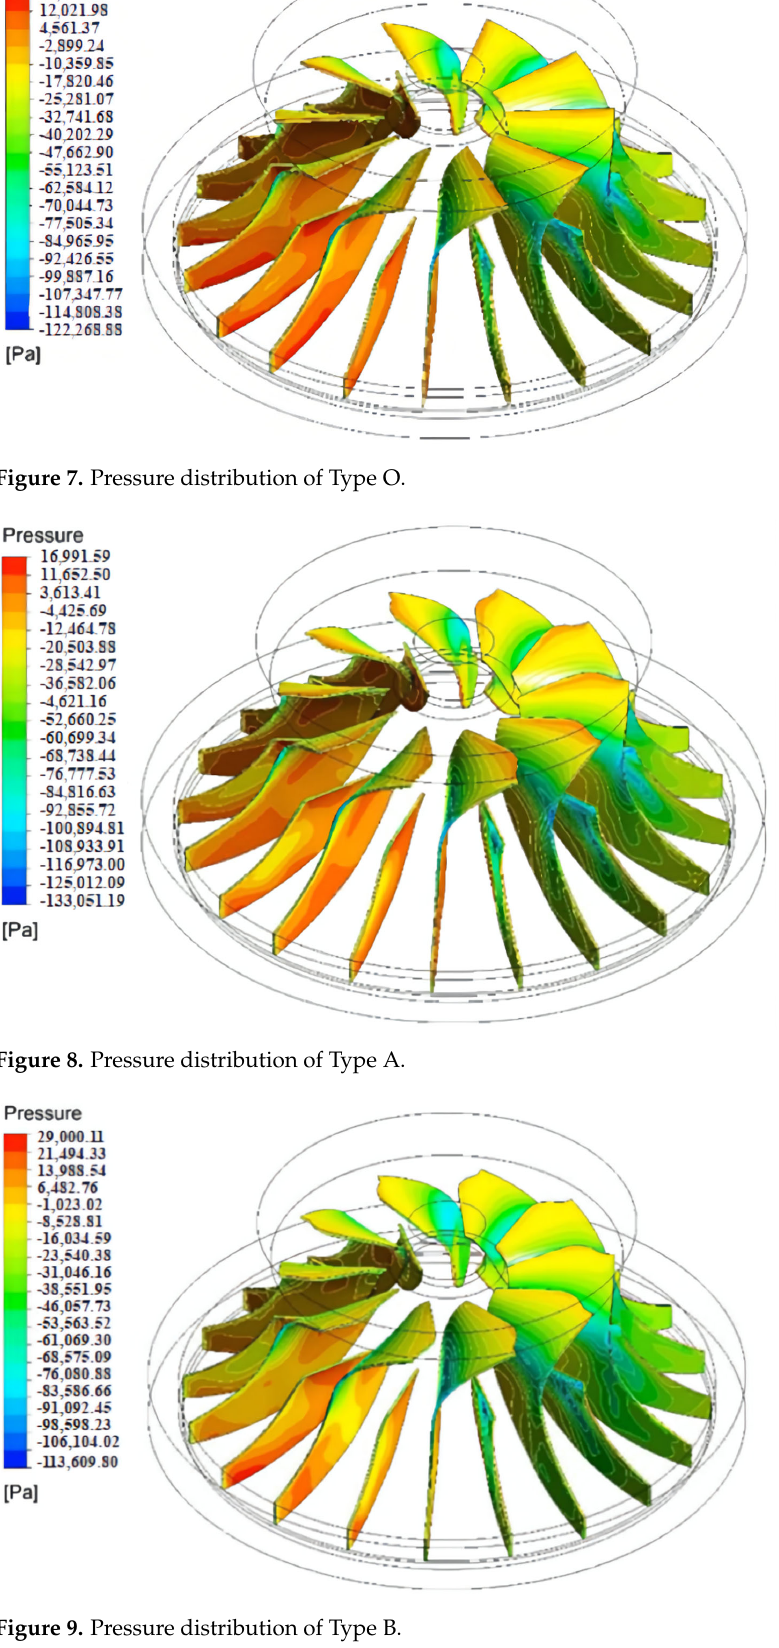
Figure 7. Pressure distribution of Type O.